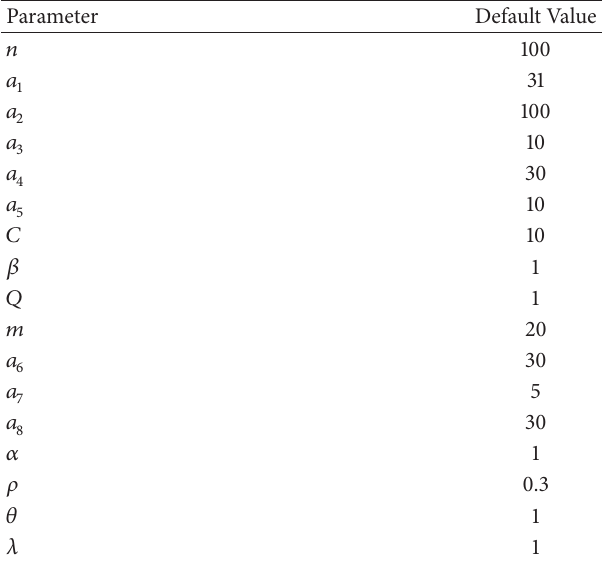
Table 1: Simulation